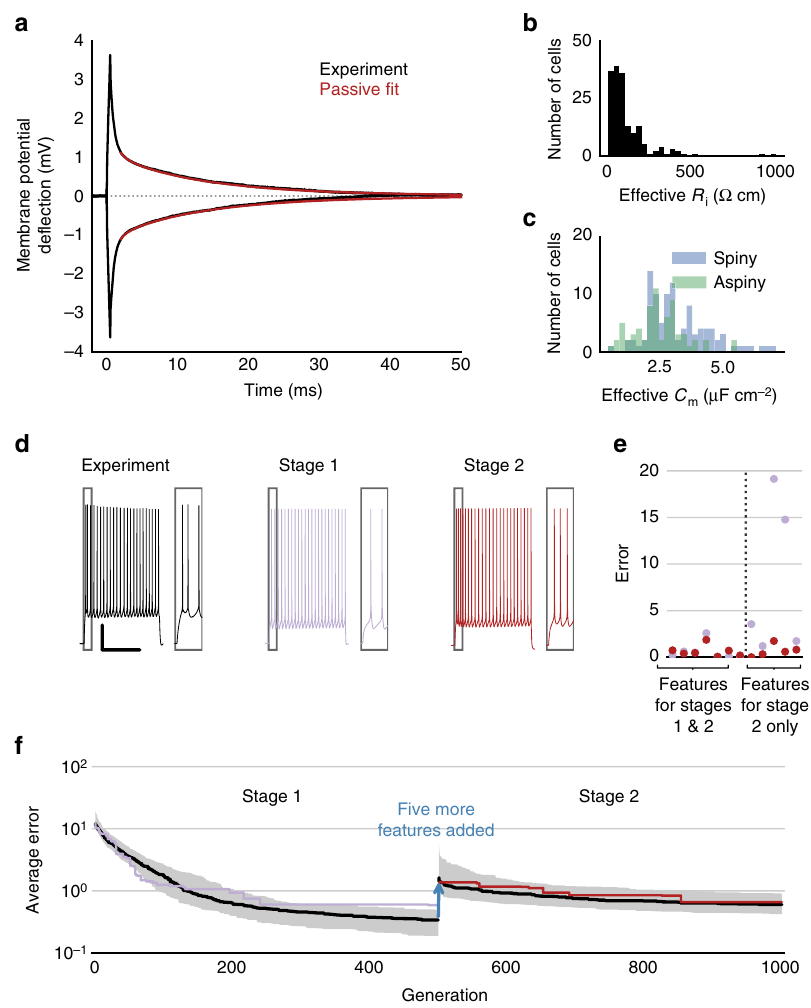
Fig. 2 Staged fi tting approach. a Direct fi tting of the return to baseline after a de- and hyperpolarizing current step (0.5 ms, ± 200 pA) with an all-passive model. b Distribution of effective speci fi c intracellular resistivity values ( R i ) across all models ( n = 170) determined by passive fi tting. c Distribution of effective speci fi c membrane capacitance values ( C m ). d Voltage traces from an example cell showing the experimental data used for optimization (left) and the model responses after the fi rst (middle) and second (right) stages of optimization; scale bar, 20 mV (vertical), 1 s (horizontal). Boxes highlight the initial spikes. e Individual feature error values (de fi ned as absolute z-scores compared to experimental values) after the fi rst stage (purple) and second stage (red). Note that the fi rst stage values to the right of the dashed line are high because those features were not part of the error function in the fi rst optimization stage. f Average error (absolute z -score) across all features for the best model in a given generation. Black shows the median values across all models, and the gray region shows the interquartile range. Purple and red traces show the speci fi c error trajectory for the cell in d and e . Note that the jump at generation 500 occurs because fi ve new features are introduced, and the average error at the end of stage 2 is higher than at the end of stage 1 because it is more dif fi cult to reduce the error across 12, rather than 7,